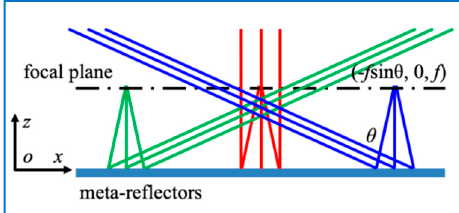
Figure 1. Quadratic meta-reflectors. The colorful lines represent the light beams with different incident angles θ and the focal spots at the positions with coordinates ( − f sin θ , 0, f ).